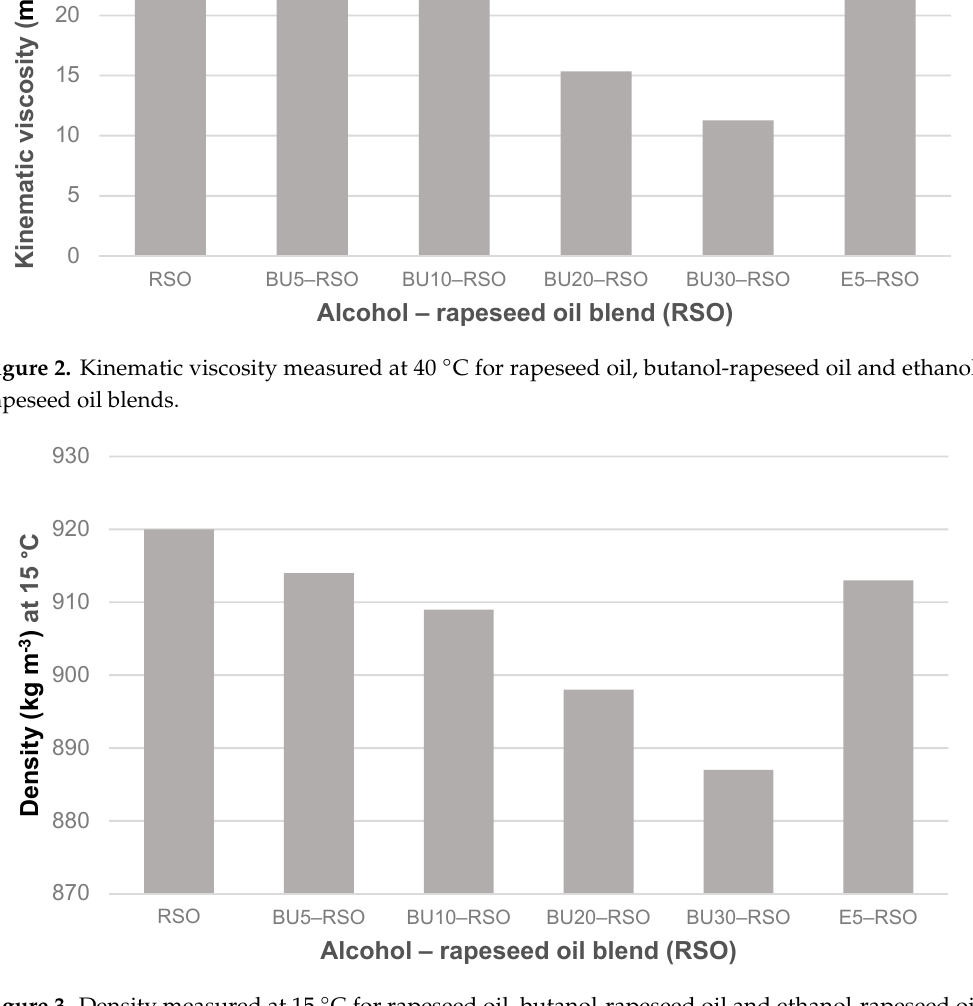
Figure 3. Density measured at 15 °C for rapeseed oil, butanol ‒ rapeseed oil and ethanol ‒ rapeseed oil blends. Note that the y-axis scale starts at 870 kg m − 3 .